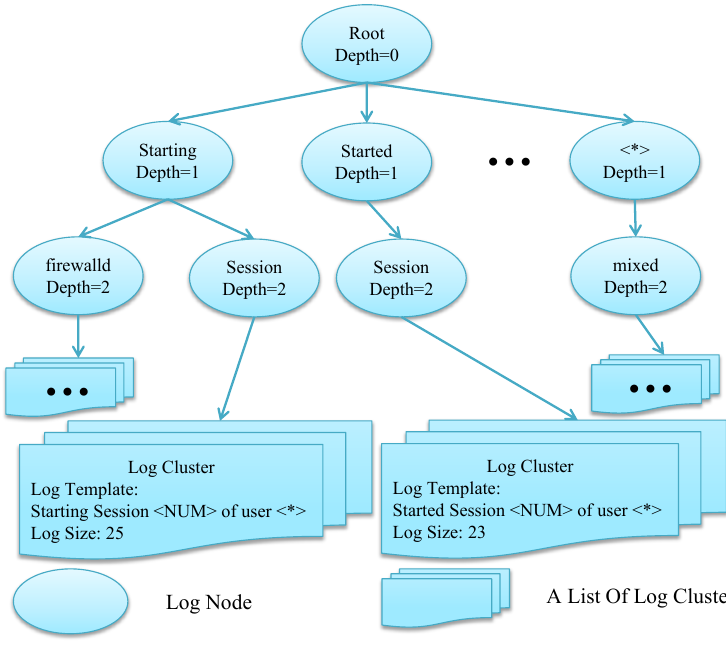
Figure 2. Figure of Log Patterns